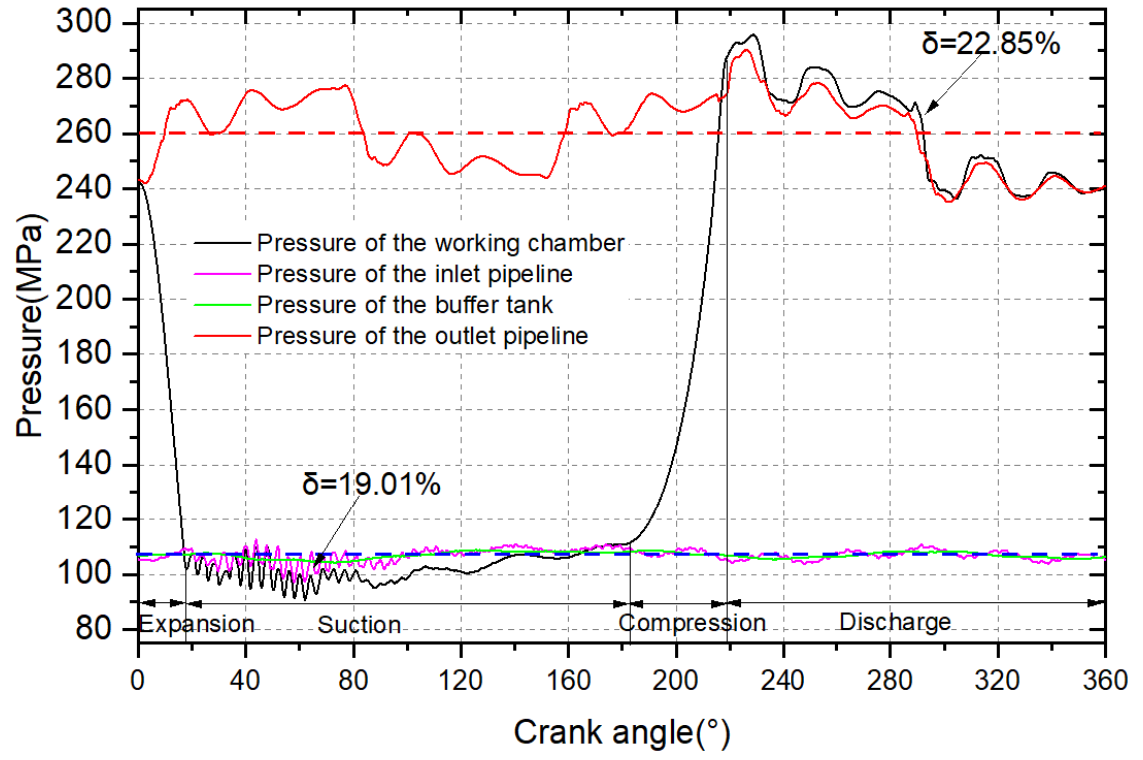
Figure 5. p- θ diagrams in the cylinder.